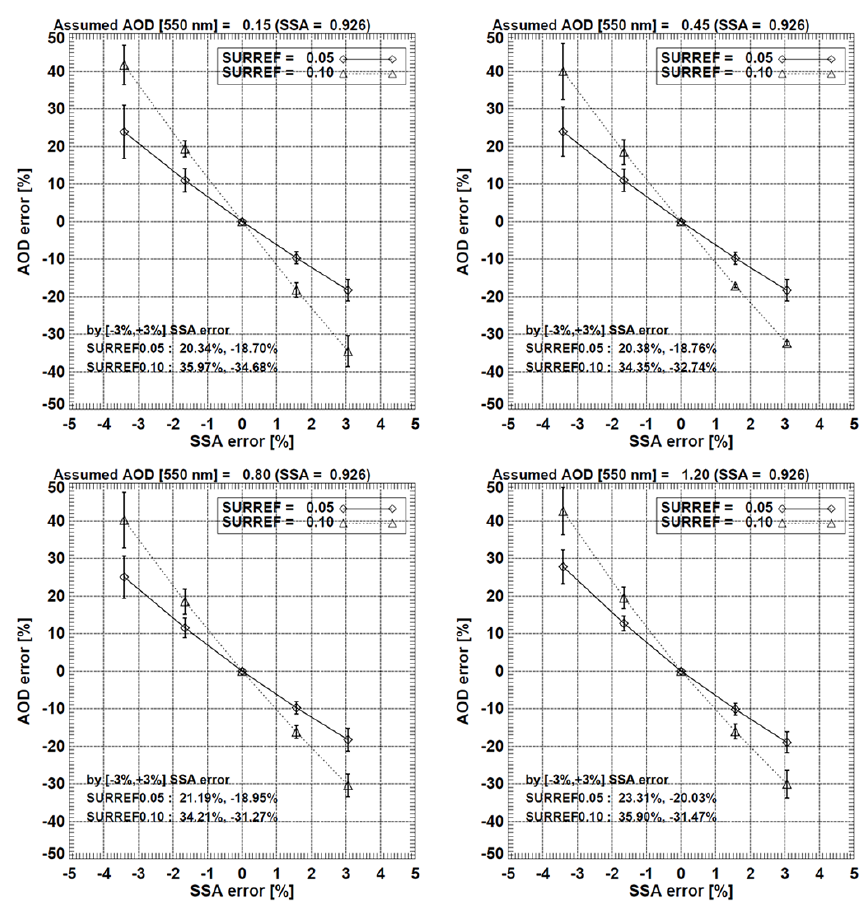
Figure 6. Dependence of the AOD retrieval error on error in assumed SSA for four different AOD cases. The SSA error represents the percentage difference between SSAs used in the simulation and the retrieval, and the AOD error indicates the difference between the retrieved AOD and a reference value. Surface reflectance is assumed to be 0.05, and scattering angles ranging from 135.73 ◦ to 173.23 ◦ are applied. The error bars indicate the standard deviation of AOD error obtained from the geometric variation, and the numbers in parentheses are the SSA error without the inversion